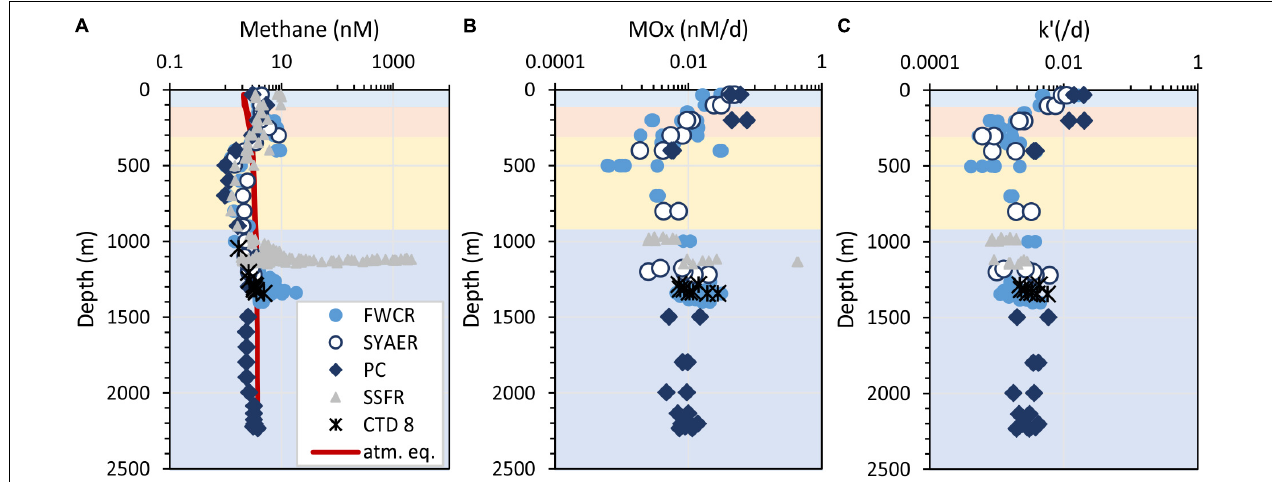
FIGURE 4 | Depth profiles of methane concentrations (A) , aerobic methane oxidation rates (B) , and the relative activity of methanotrophic microorganisms – k’ (C) . Horizontal colors refer to the water masses: surface water – blue, subsurface water – orange, intermediate water – yellow, and deep water – dark blue. The red line in (A) indicates the methane concentration in atmospheric equilibrium, i.e., values greater than the equilibrium concentrations suggest a source of methane. Symbols refer to the different sampling areas. Station CTD-8 located at FWCR was excluded, because these results display the difference, which results from sampling after a gas emission was caused by seabed drilling and the drilling rig was